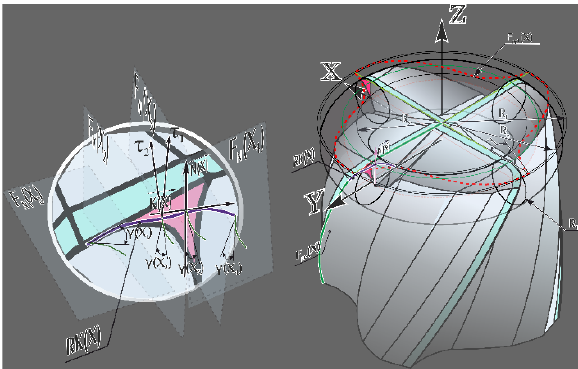
Fig. 2. Main geometrical parameters of toroid-shaped solid ceramic end mill The shape of the cutting edge is defined as the spatial line of intersection of the producing toroidal surface (3) with the helical rake surface